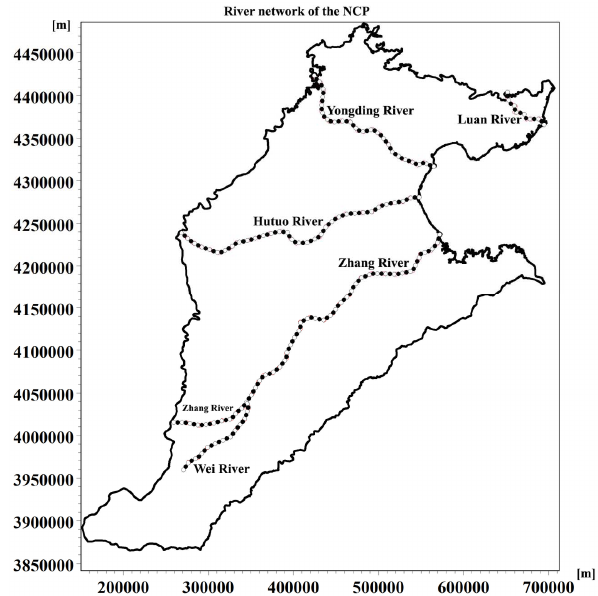
Fig.4. River network of the NCP (IWHR), including 5 major rivers: Luan River, Yongding River, Hutuo River, Zhang River and Wei River. The x and y axis represent the horizontal and vertical directions in unit of meter.